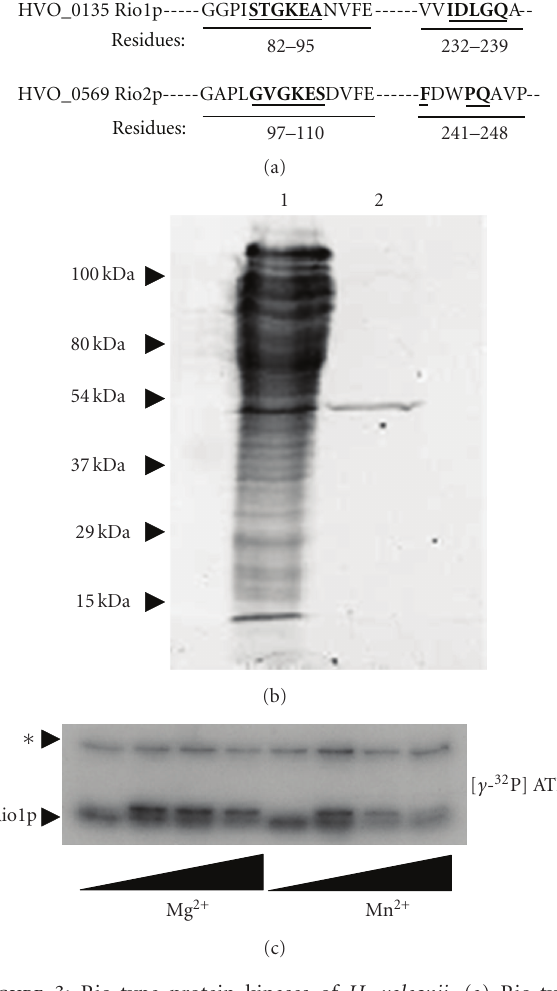
Figure 3: Rio-type protein kinases of H. volcanii . (a) Rio-type protein kinase homologs of H. volcanii , type-1 (HVO 0135) and type - 2 - like (HVO 0569), with conserved amino acid residues in bold and underlined. While HVO 0569 does not have a complete C- terminal domain, it does contain three of the five conserved residues of Rio type-2 kinases. (b) Purification of Rio1p (HVO 0135) from H. volcanii . Reducing SDS-PAGE gel of cell lysate (lane 1) and Rio1p purified by StrepTactin chromatography (lane 2) from in H. volcanii -pJAM2558. (c) Rio1p catalyzes its autophosphorylation. Autophosphotransfer was detected in vitro by autoradiography using [ γ - 32 P] ATP as a substrate with optimal activity detected at 10 to 50 mM MgCl 2 . ∗ , identity of band remains to be